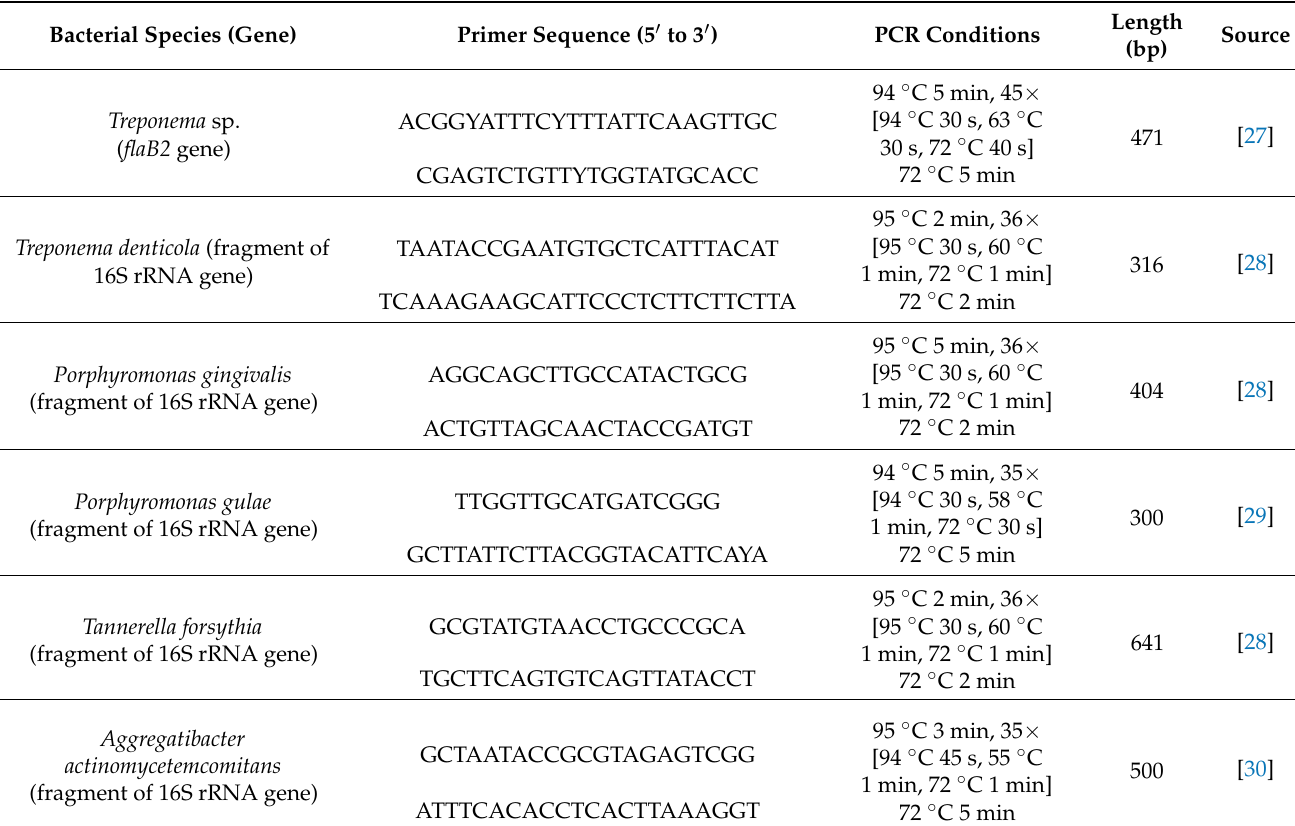
Table 1. Primers and PCR conditions used to detect periodontal